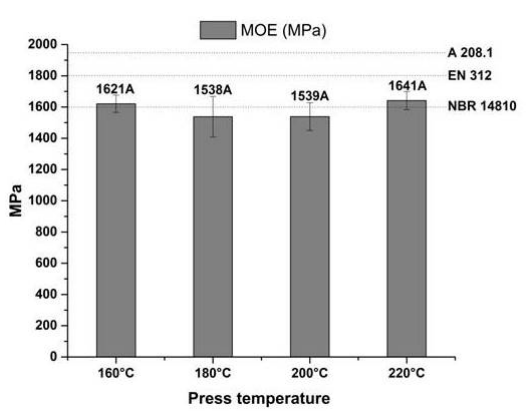
Figure 6. Modulus of elasticity (MOE) for particleboard panels produced with sugarcane bagasse particles at different pressing temperatures. * Averages followed by similar letter did not differ statistically by the Scott-Knott test at 5% significance level.